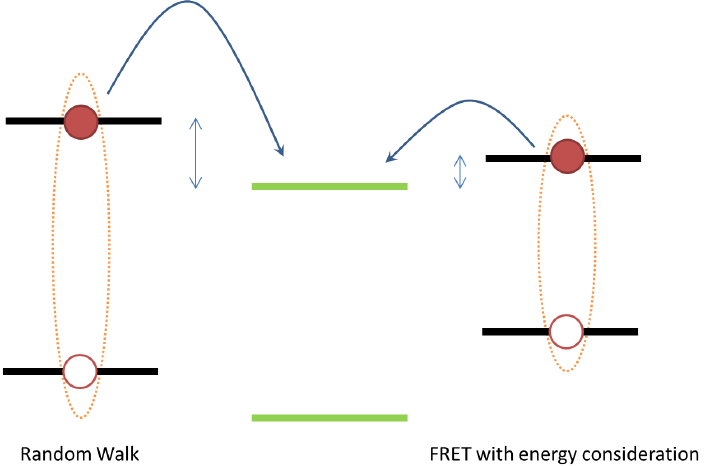
Figure 8. The average energy of an exciton at dissociation in a p-type molecule when ( left ) exciton transport is modelled using a simple random walk and ( right ) energy relaxation is taken into account. The energy levels of an n-type molecule are shown in green. The LUMO offsets are indicated for both